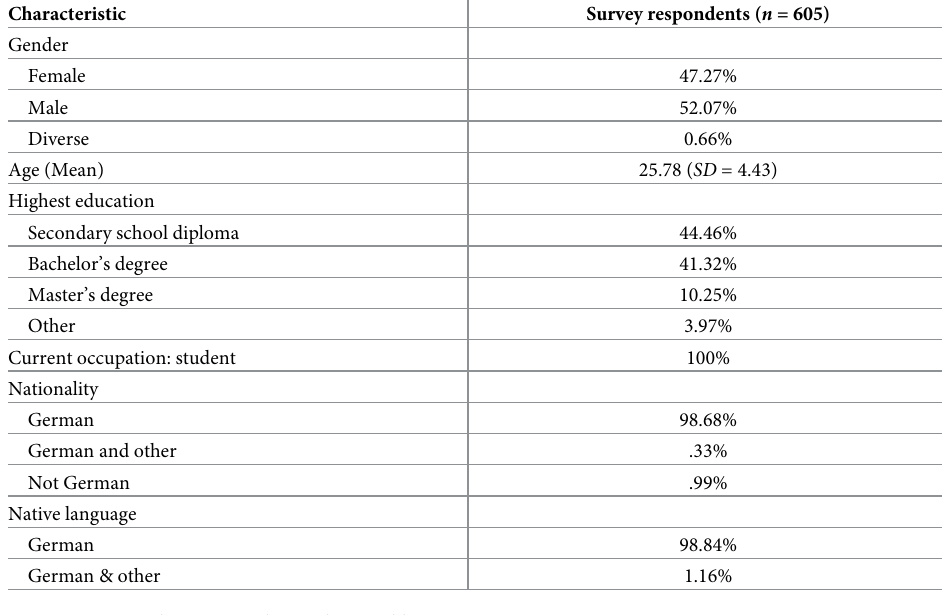
Table 2. Demographic details of study